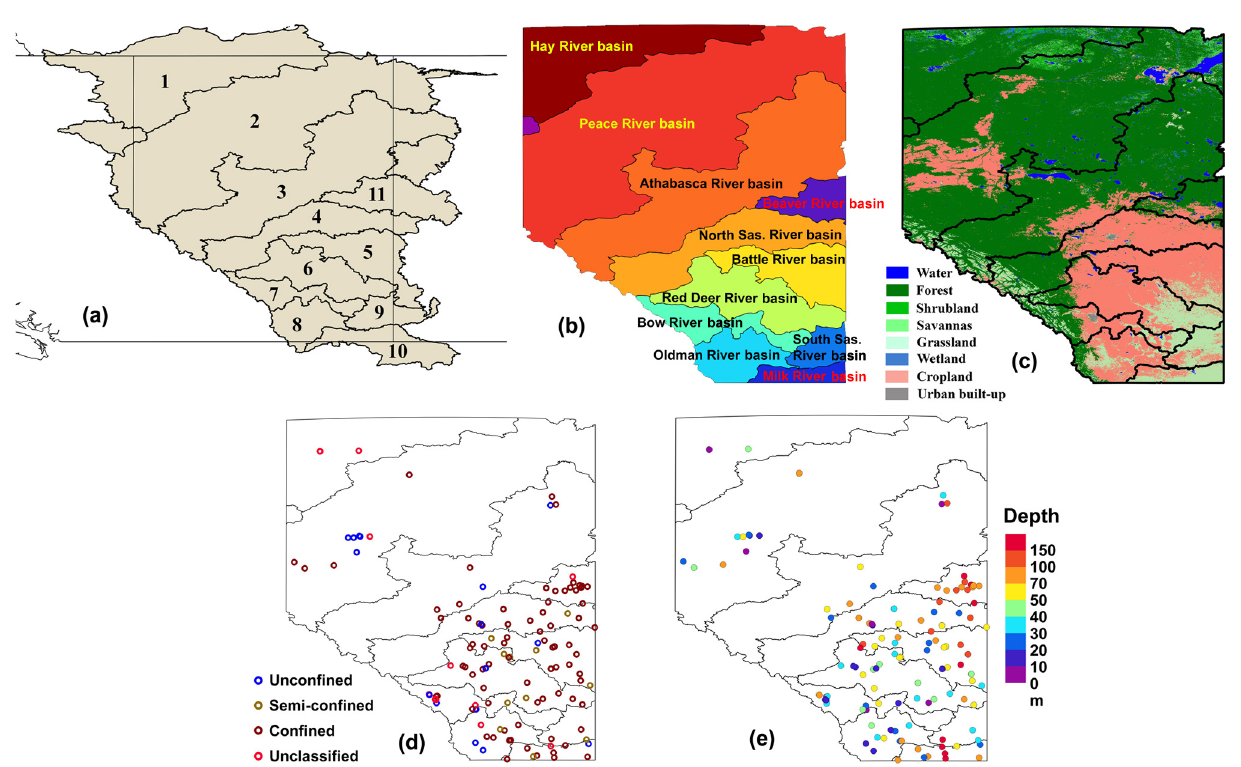
Figure 1. Major river basins in Alberta. (a) Full basin extent; (b) Alberta only; (c) dominant land cover types; (d) aquifer types represented through the studied wells; (e) depth of wells screened in Alberta, overlaid by basin